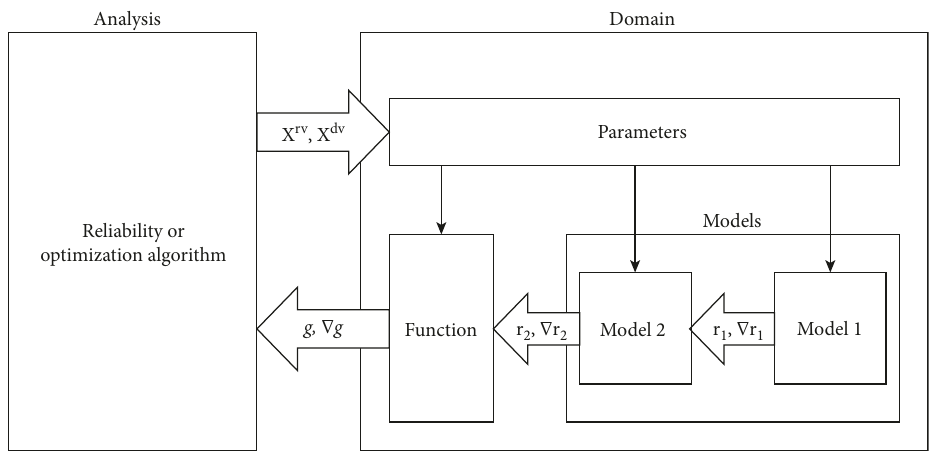
Figure 6: Overview of the analysis method in RT. Table 2: Results of reliability analysis of the frame of a cold-rolled steel frame by RT program. FORM